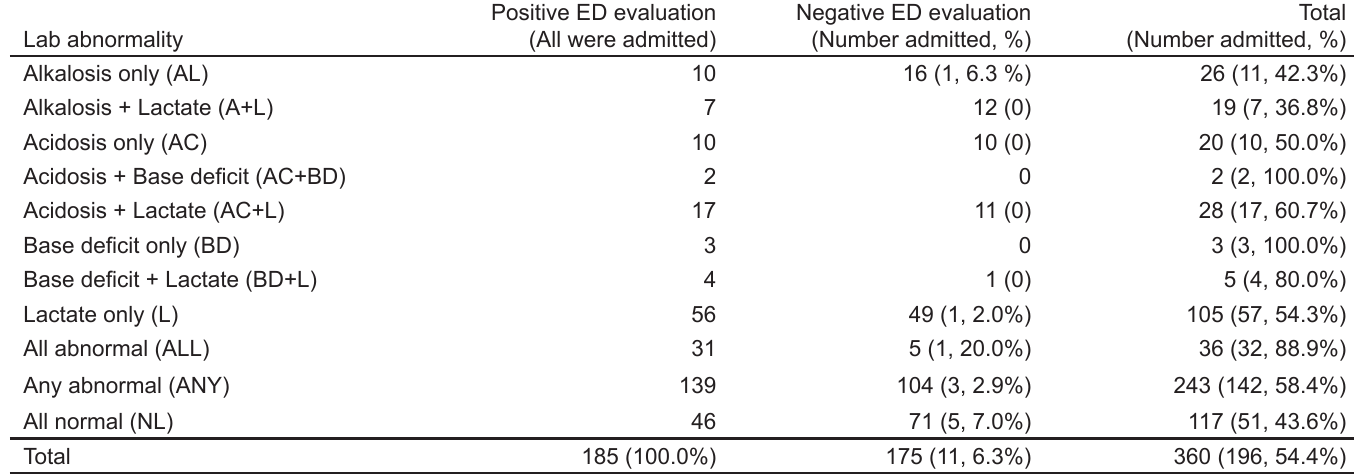
Table 2. Abnormal arterial blood gas and serum lactate (ABG / SL) by emergency department (ED)